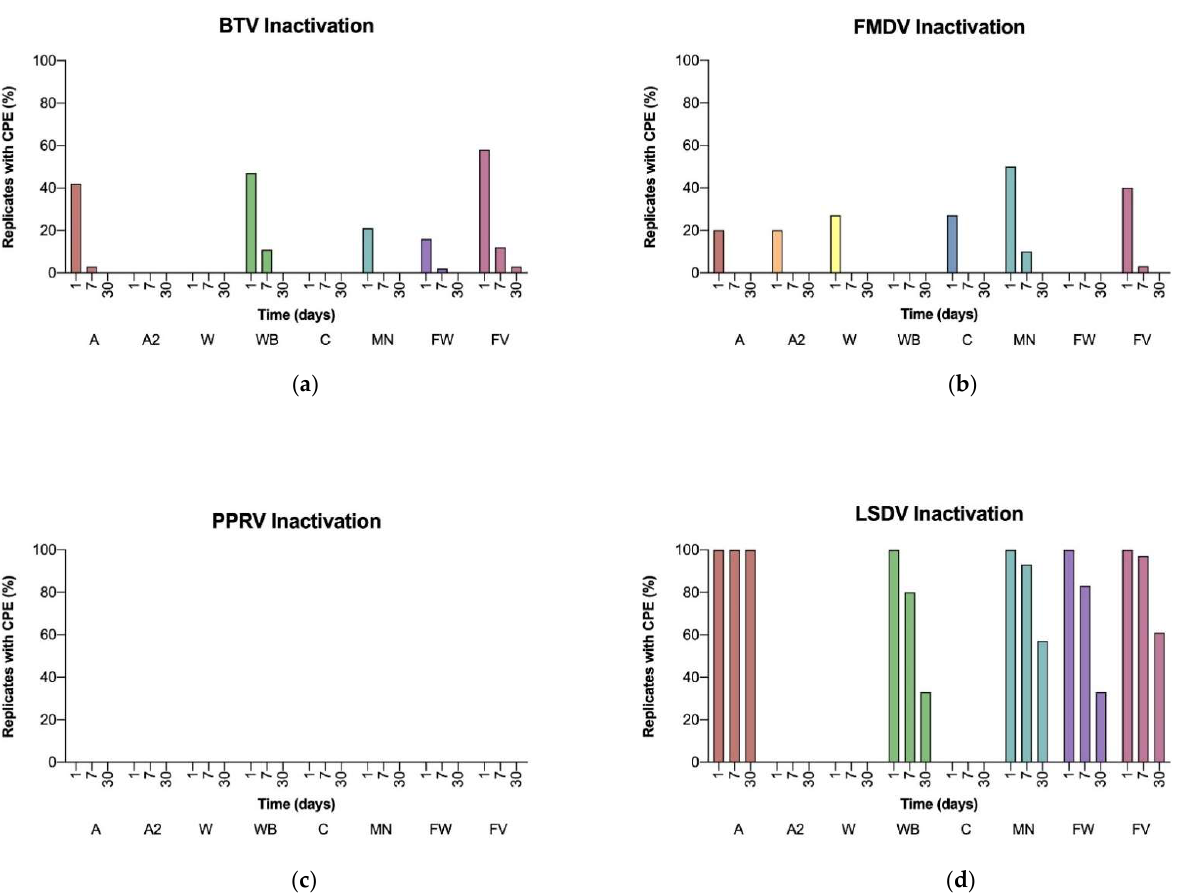
Figure 1. Virus inactivation on cards and filters during one day, one week, and one month of incu- bation. The percentage of all replicates still causing CPE in cell culture is shown for each virus, card, or filter and time. ( a ) BTV; ( b ) FMDV; ( c ) PPRV; ( d ) LSDV.